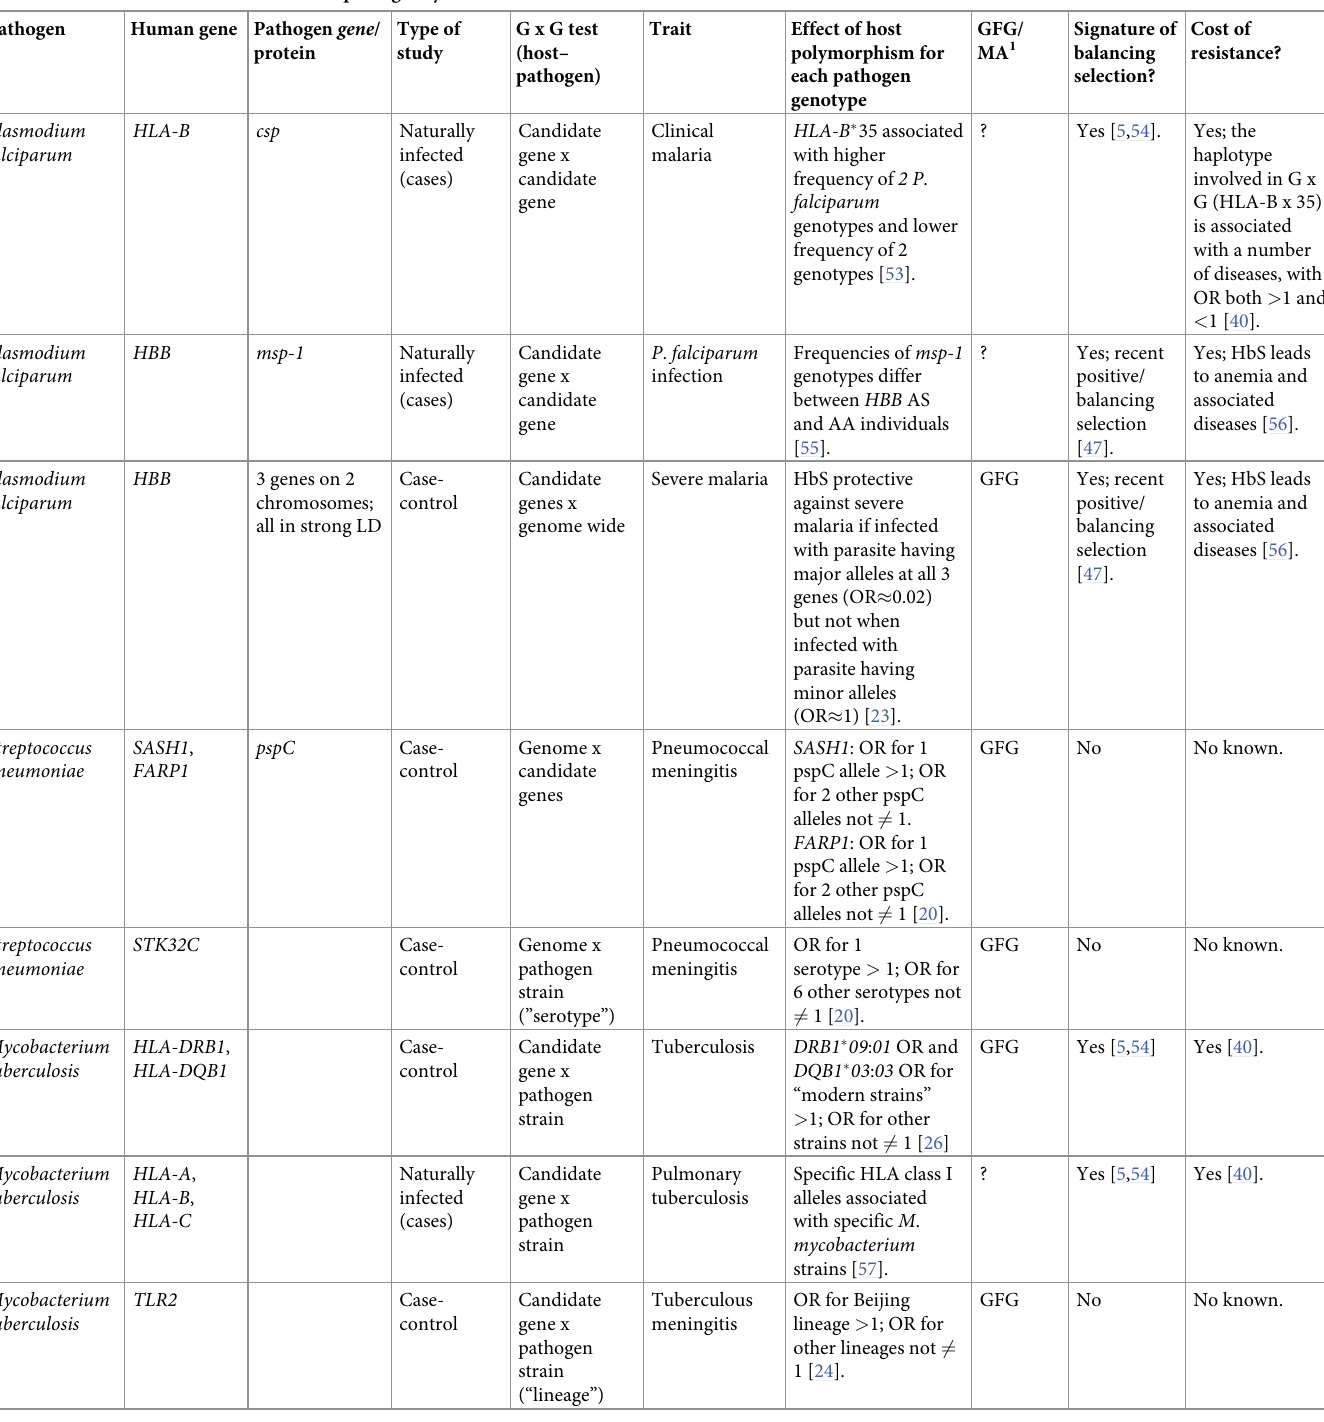
Table 1. Evidence for G × G in human host–pathogen